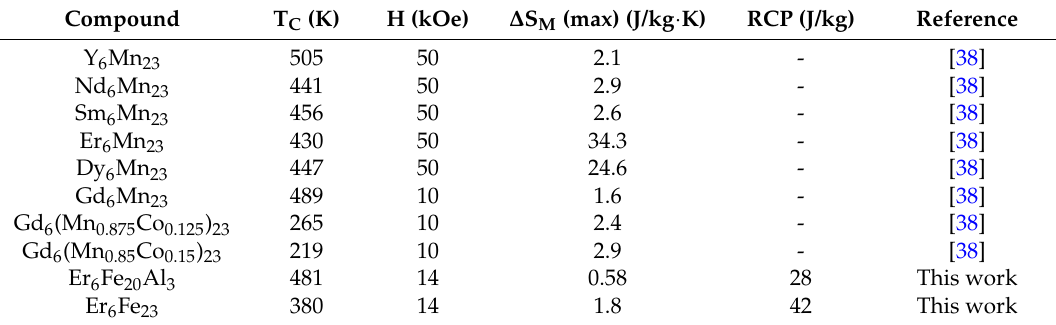
Table 3. Curie temperature T C , magnetic entropy change ( ∆ S M ), and relative cooling power (RCP)